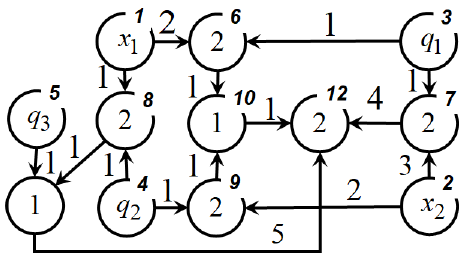
Figure 2. The NOP graph of the function